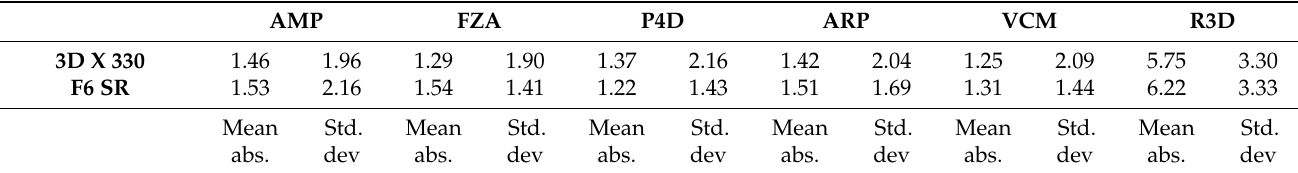
AMP FZA P4D ARP VCM R3D Mean Std. Mean Std. Mean Std. Mean Std. Mean Std. Mean Std. abs. dev abs. dev abs. dev abs. dev abs. dev abs. dev